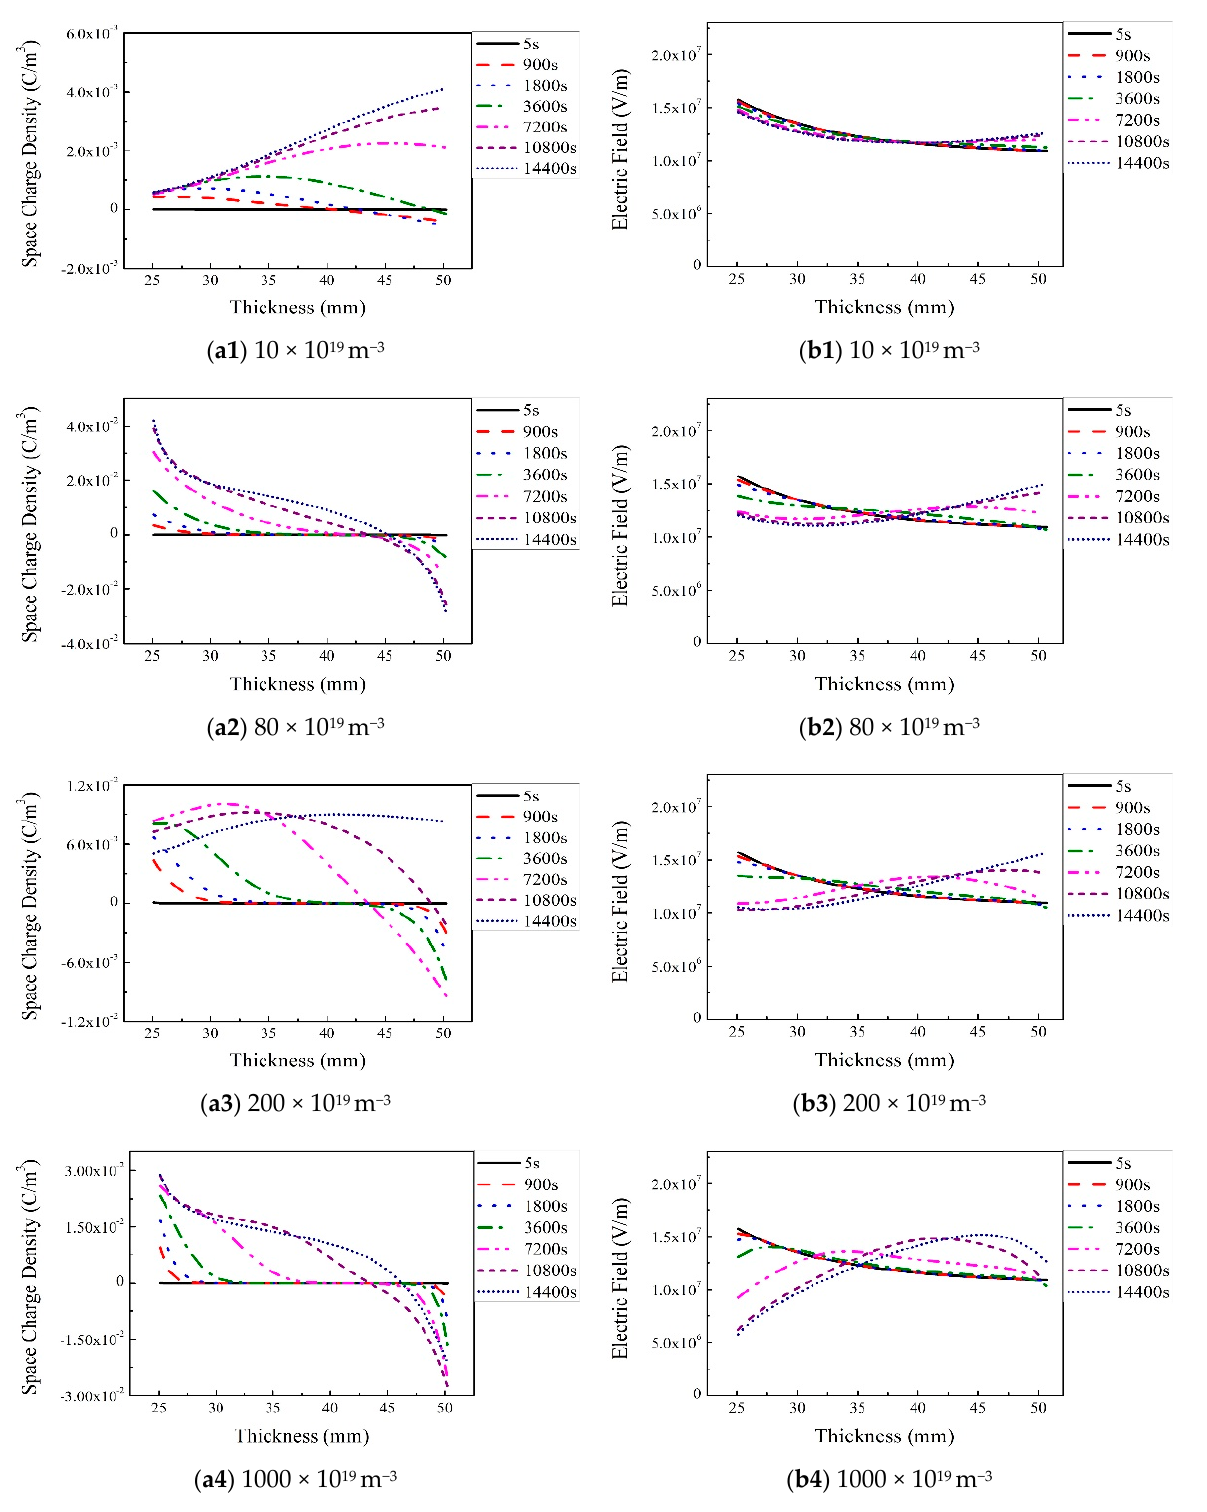
Figure 7. Simulation results of space charge distribution ( a1 – a4 ) and electric field distribution ( b1 – b4 ) in 320 kV HVDC cable insulation when the trap density varies from 10 × 10 19 m − 3 to 1000 × 10 19 m − 3 with the trap depth of 0.94 eV and load current of 1800 A.